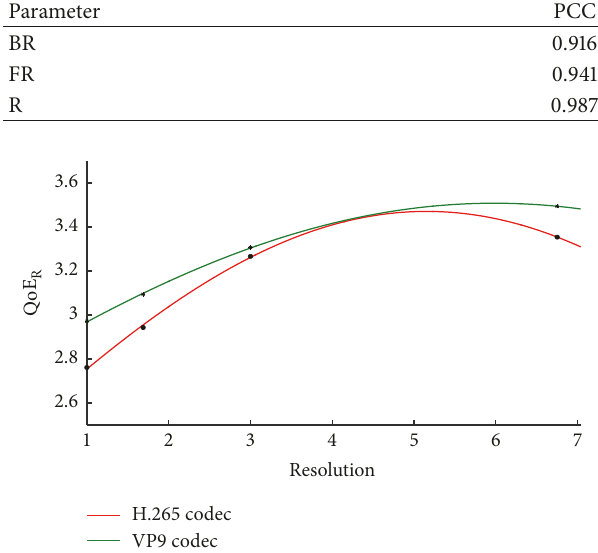
Figure 15: Relationship between resolution and QoE tive test).